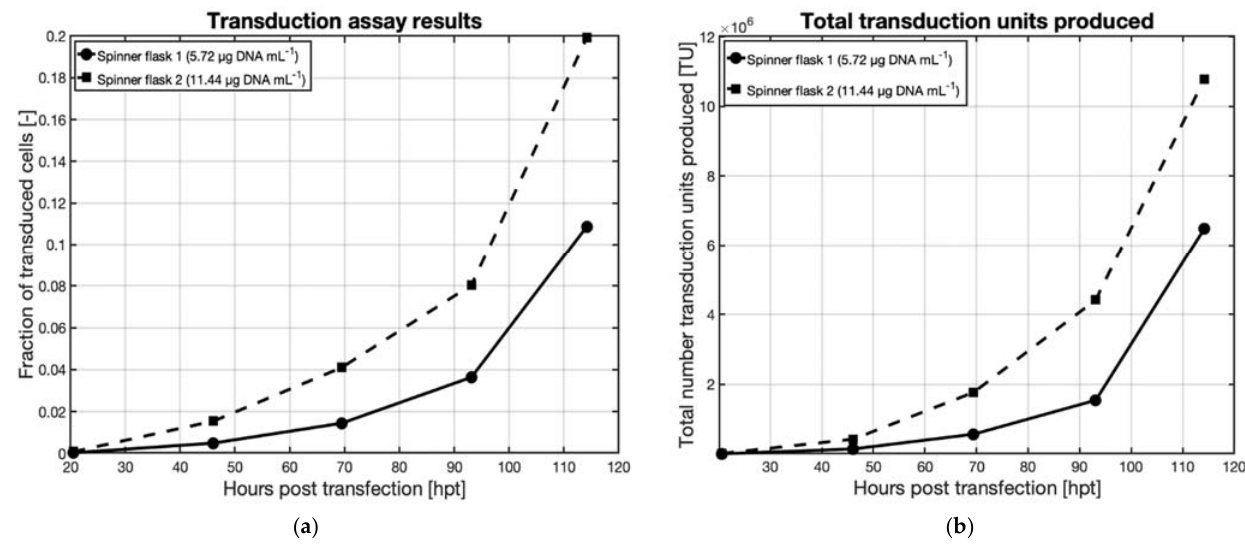
Figure 5. Effect of DNA concentration on the transfection of HEK293T cells immobilized on Cytodex 3 microcarriers in 125 mL Bellco spinner flasks, measured by transduction assays of CHO cells using supernatant samples harvested at various times from the spinner flasks with a cell density at transfection of 1.4 × 10 6 cells mL − 1 ; spinner flask 1 and 2 had final DNA concentrations of 5.72 µg DNA mL − 1 and 11.44 µg DNA mL − 1 , respectively. ( a ) Fraction of transduced CHO cells from supernatant samples at selected points post-transfection and ( b ) Total number transduction units produced in both spinner flasks, calculated from Equation (6).